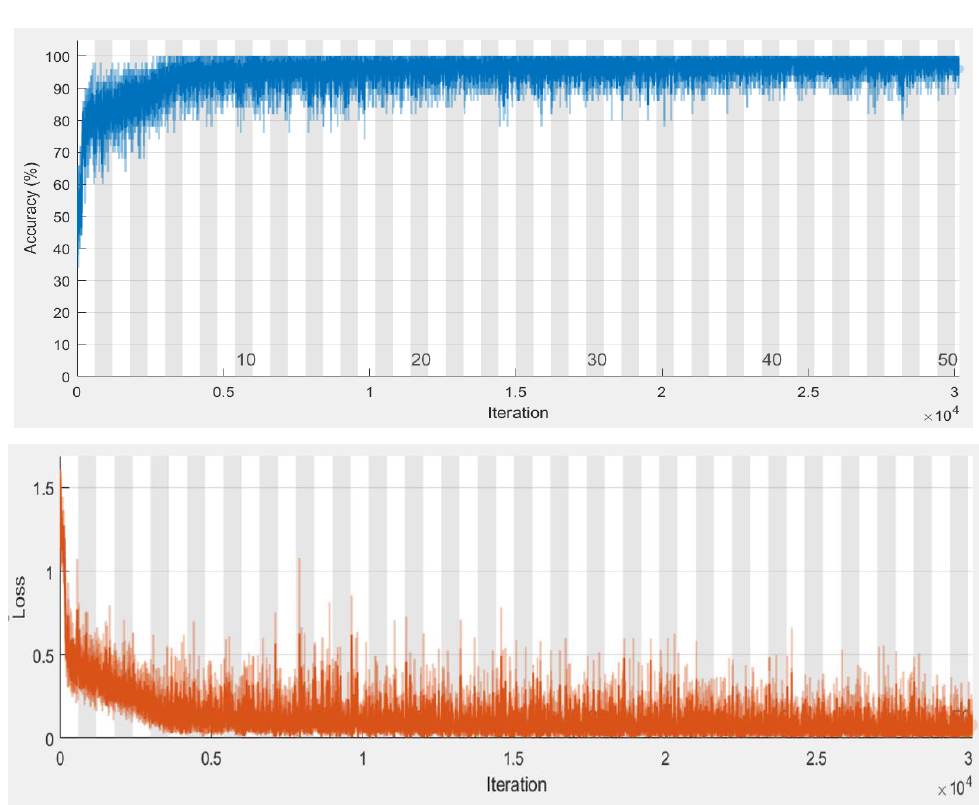
Figure 11. Training set accuracy rate curve and loss function curve.